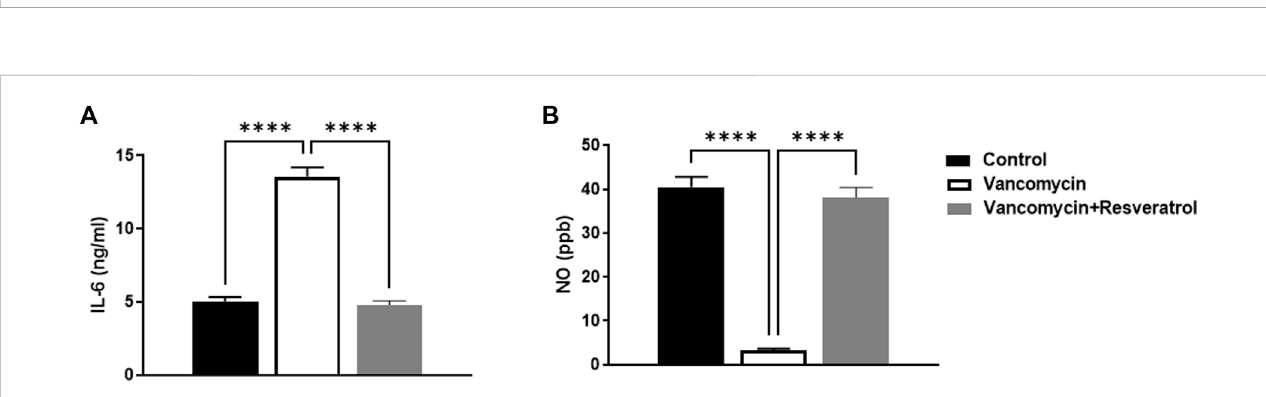
FIGURE 1 (A) Aspartate transaminase (AST) levels in u/l, (B) Alanine aminotransferase (ALT) in u/l, (C) Alkaline phosphatase (ALP) in unit/liter (u/l), and (D) lactate dehydrogenase (LDH) (IU/L), were measured in the control rats, rats injected with vancomycin only, and rats injected with vancomycin and resveratrol. Signi fi cant difference: ns = non-signi fi cant, ** p < 0.001 **** p < 0.0001.